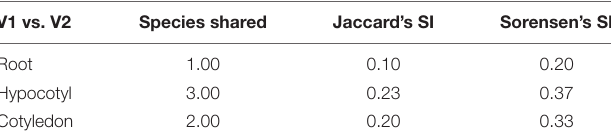
TABLE 2 | Comparison of different similarity indices among various regions of two organic varieties of tomato. V1 vs. V2 Species shared